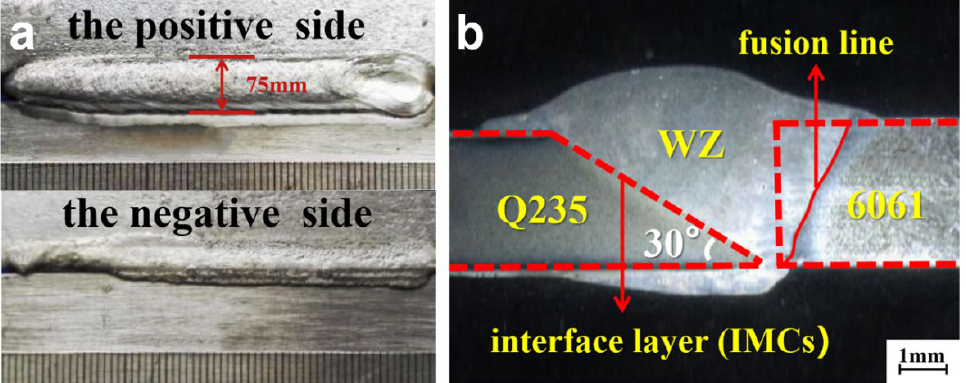
Figure 4. Morphology of welded joint: ( a ) appearance of the weld zone; ( b ) cross-section of the weld zone.